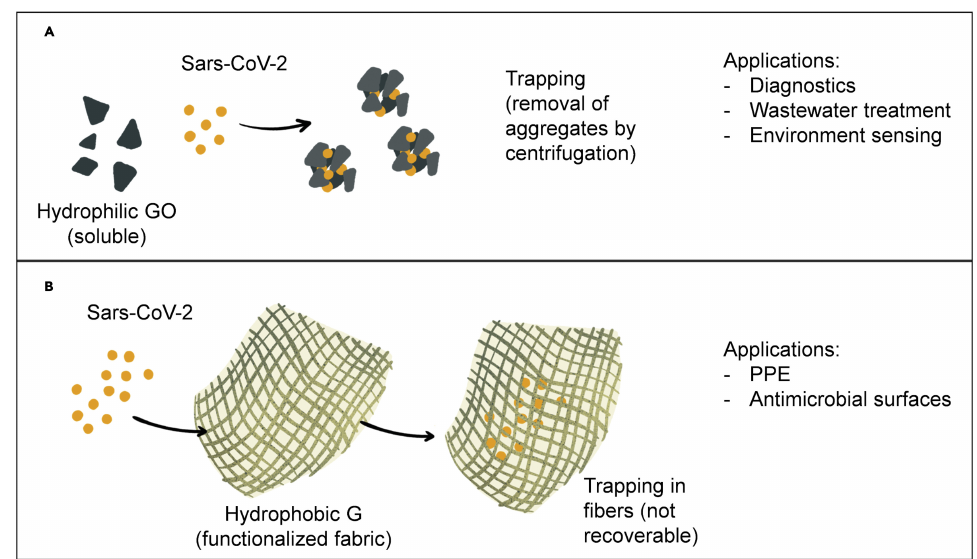
Figure 13. Schematic preparation and potentential applications of nanohybrid systems based on ( A ) hydrophilic GO and ( B ) hydrophobic graphene materials employed to defeat SARS-CoV-2. Figure reprinted from Ref. [173] under the terms of the Creative Commons CC-BY-NC-ND